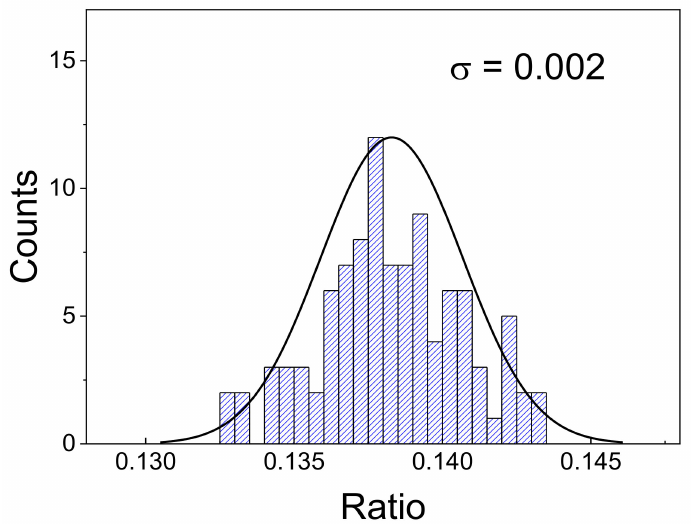
Figure 7. Distribution of the measured parameter (LIR) and the corresponding standard